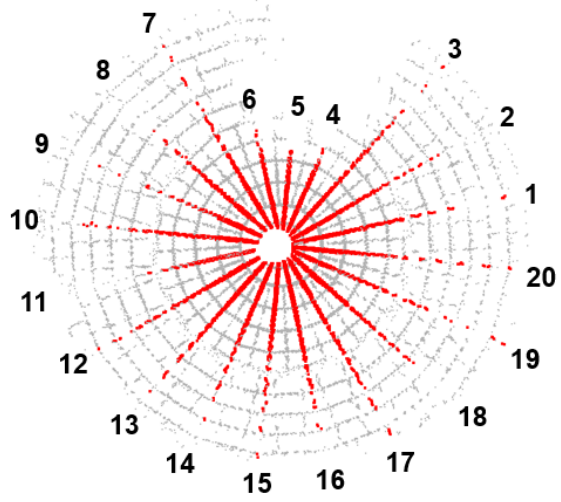
Figure 36. Extracted stringer features and the corresponding feature IDs for the Lebanon dataset. Table 4. RMS of the fitting error for the registration primitives ( roof and stringers ) in the Lebanon dataset following the partial/full fine registration.